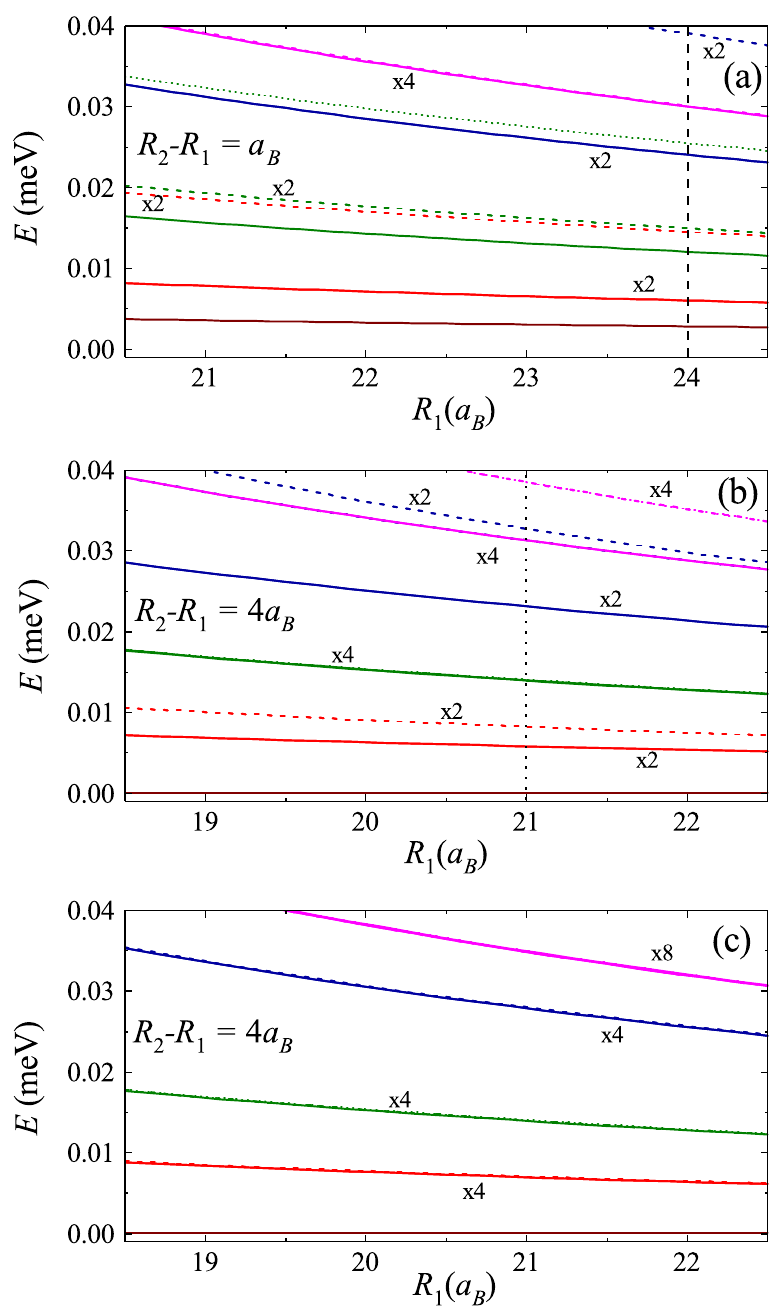
Figure 4. ( a ) Two exciton energy spectrum as function of ring radii for the fixed distance between the rings R 2 − R 1 = a B . In the regime of small distance between the rings, the strong Coulomb interaction leads to large splitting between the corresponding pairs of states. ( b , c ) The energy spectrum for the ring distance R 2 − R 1 = 4 a B ( b ) with and ( c ) without the mixing of center of mass and relative dynamics, respectively. In the regime of large distance between the rings the strong mixing lifts the degeneracy between corresponding states. The vertical lines illustrate the equivalence with the corresponding points in Figure